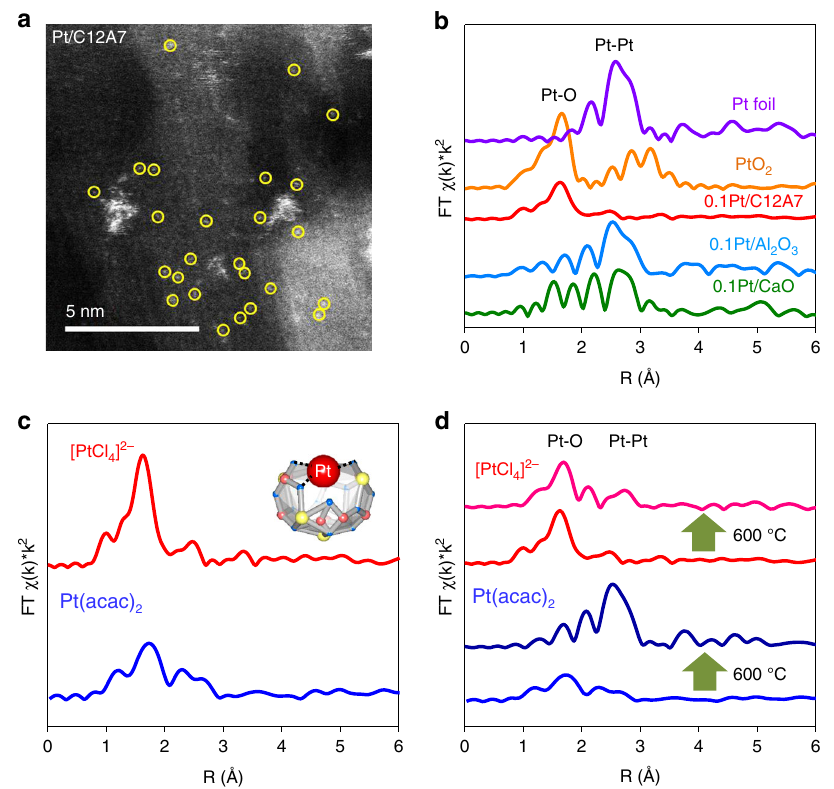
Fig. 2 Characterizations of Pt/C12A7 with other reference Pt catalysts. a HAADF-STEM image of 0.1Pt/C12A7 single-atom structures. Single Pt atoms marked in yellow circles are uniformly dispersed on the C12A7 support. b Pt K-edge EXAFS spectra in R space for 0.1Pt loaded on various supports, such as Al 2 O 3 and CaO. c , d Pt K-edge EXAFS spectra in R space for 0.1Pt/C12A7 with various Pt precursors and elevated reduction temperatures. Table 1 EXAFS fi tting results for different Pt catalysts.